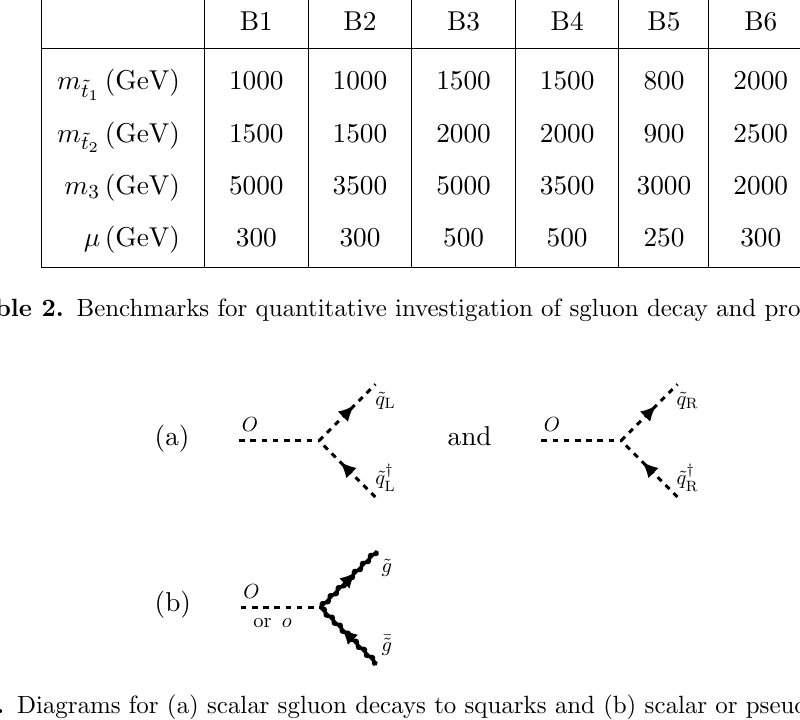
Figure 1. Diagrams for (a) scalar sgluon decays to squarks and (b) scalar or pseudoscalar decays to